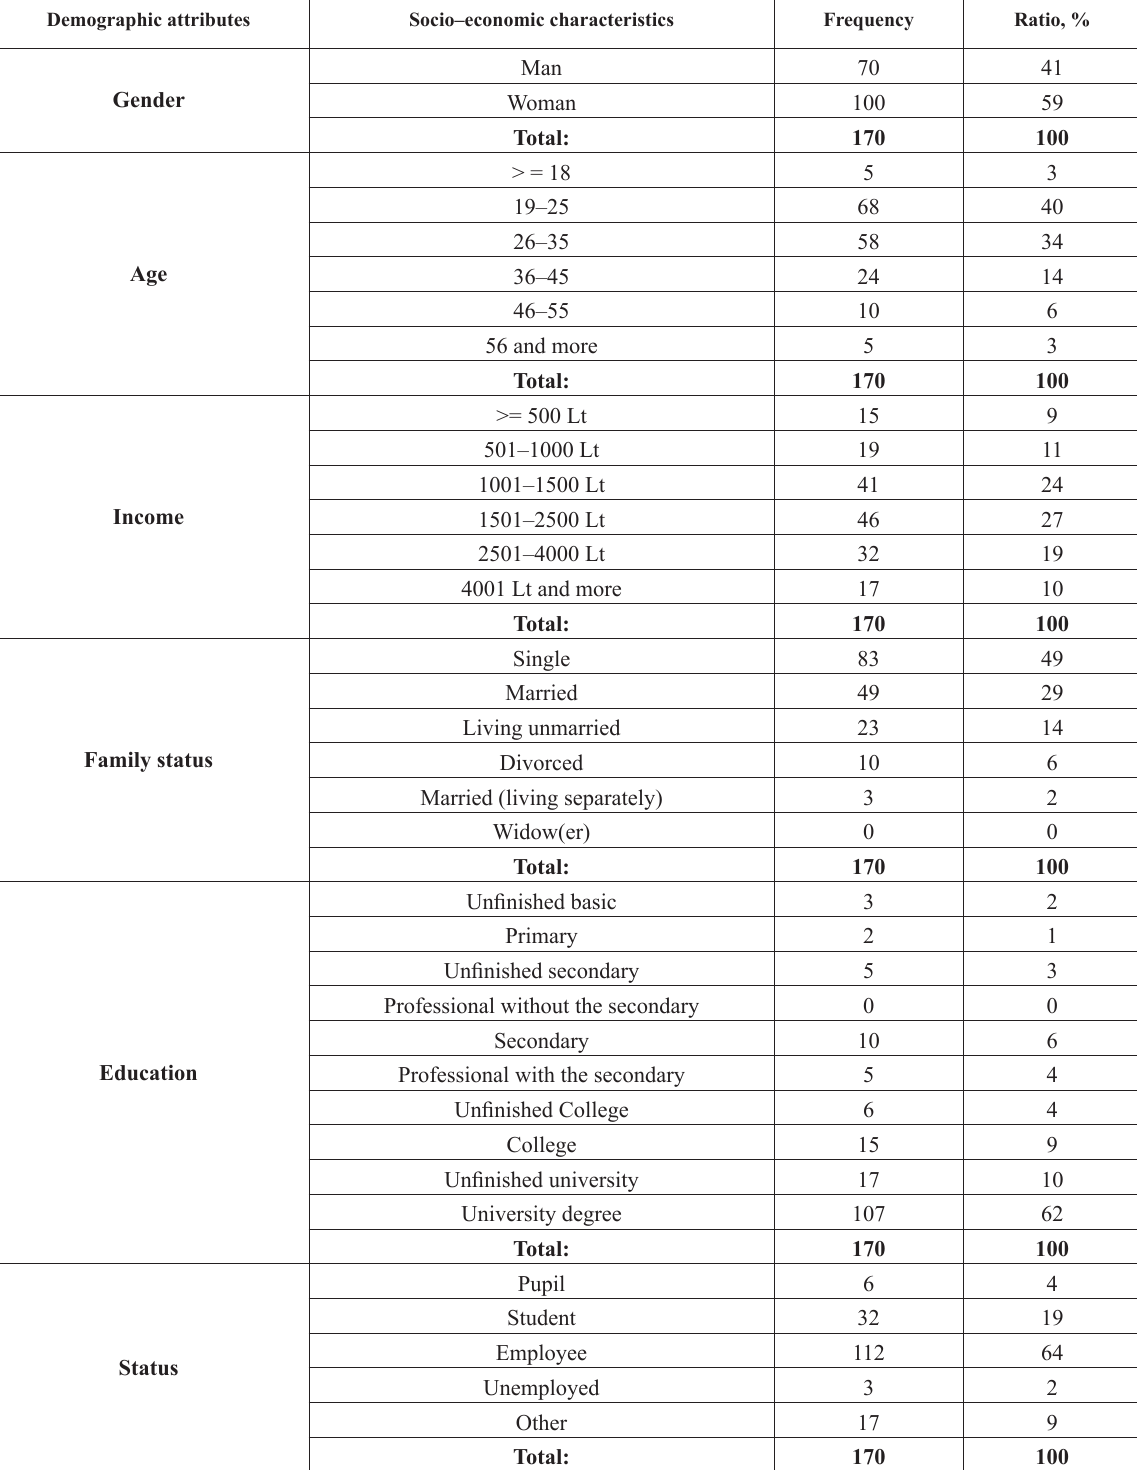
Table 1. Demographic and socio-economic characteristics of respondents Demographic attributes